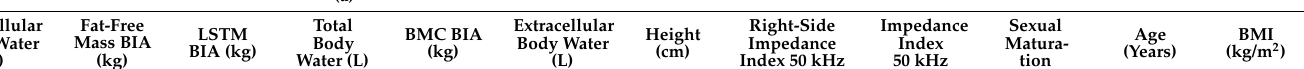
Table 3. Correlation matrix for study variables (Spearman correlation